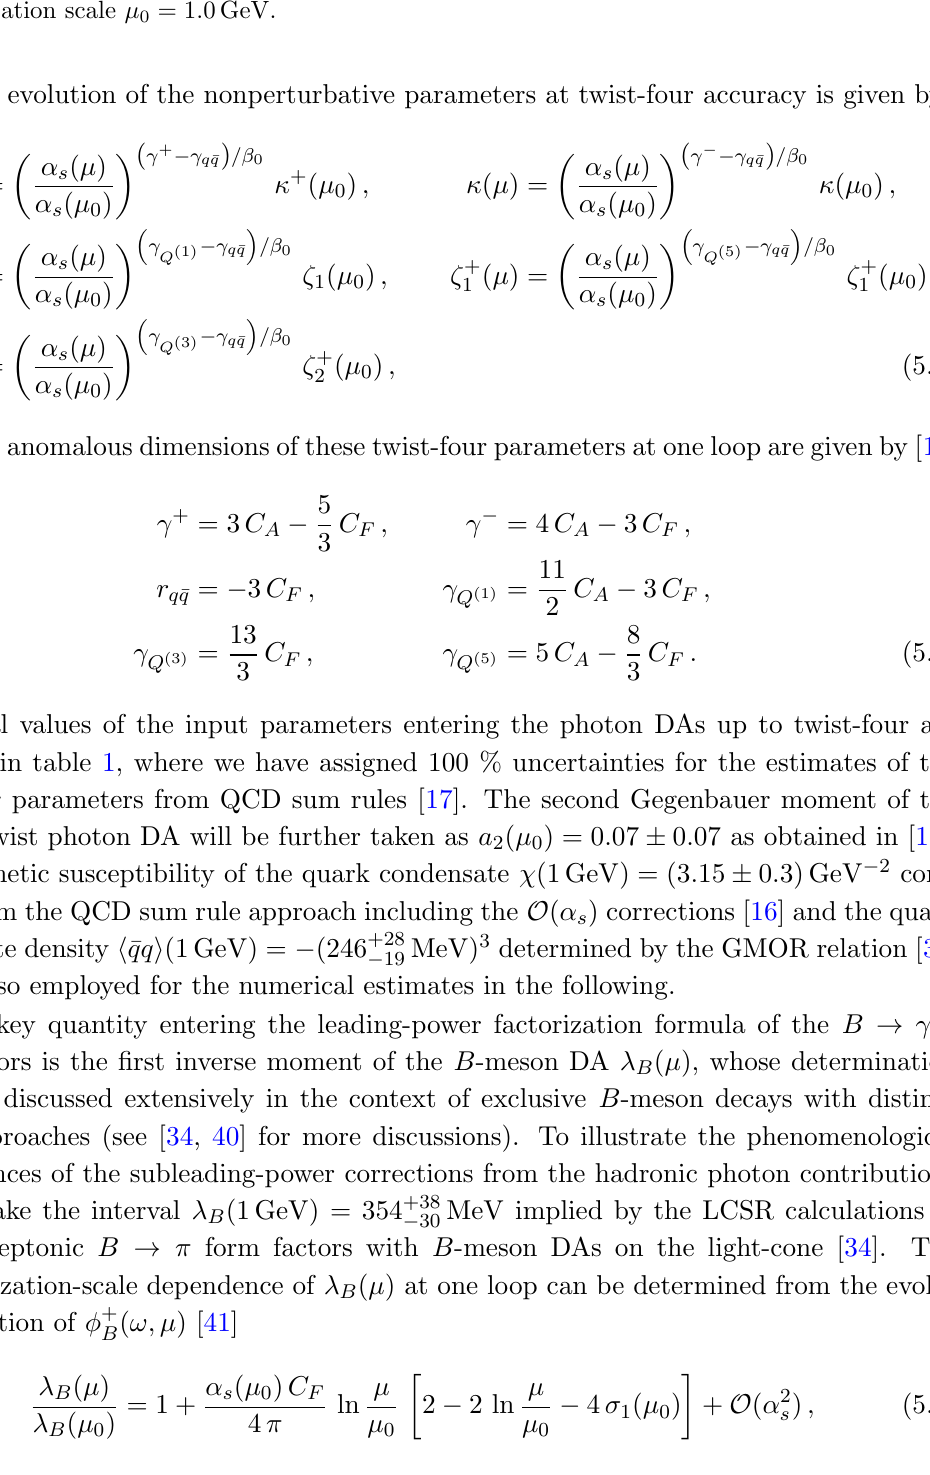
Table 1 . Numerical values of the nonperturbative parameters entering the photon DAs at the renormalization scale (cid:22) 0 = 1 : 0